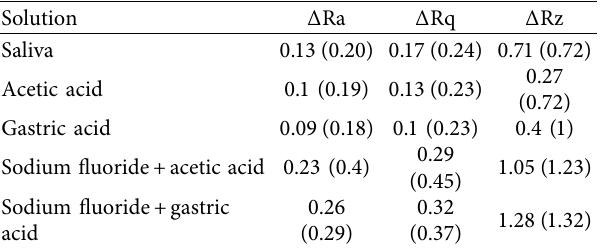
Table 2: Mean and standard deviation of changes in Ra, Rq, and Rz parameters of IPS e.max CAD before and after immersion in different solutions.